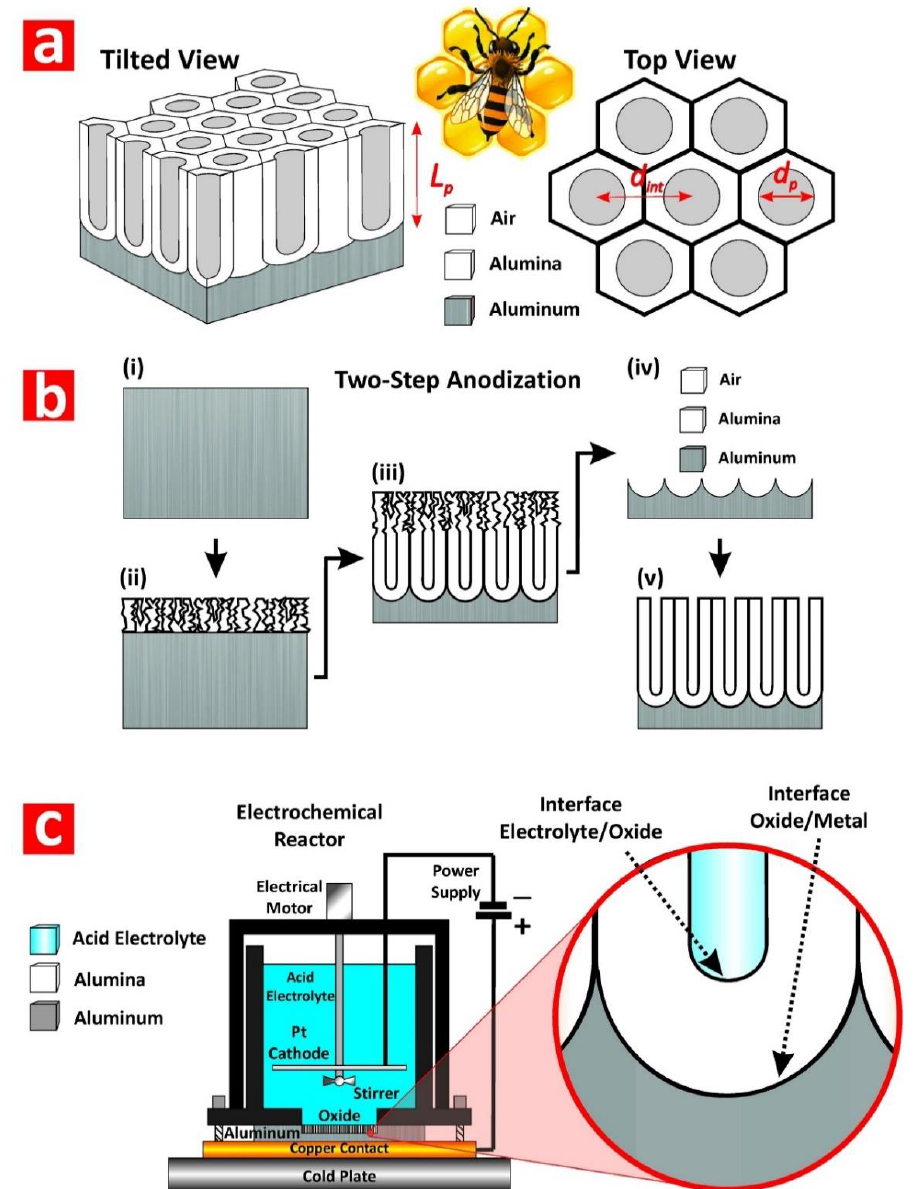
Figure 2. Self-organized nanoporous anodic alumina (NAA). ( a ) Structure and geometric features of NAA produced by two-step anodization with tilted 3D view of NAA structure ( left ) ( L p —nanopores length) and top view of NAA structure ( right ) ( d int —interpore distance and d p —nanopores diameter). ( b ) Schematic diagram illustrating the two-step anodization process: ( i ) aluminum substrate, ( ii ) nanopores nucleation—first step, ( iii ) nanopores development—first step, ( iv ) sacrificial oxide layer removal, and ( v ) cross-sectional view of self-organized NAA structure—second step. ( c ) Schematic illustration of an electrochemical reactor used to NAA by anodization ( left ) and details of the oxide barrier layer located at the bottom tip of the nanopores where the electrochemical reactions (i.e., oxidation and dissolution) occur at the interfaces metal/oxide and oxide/electrolyte.